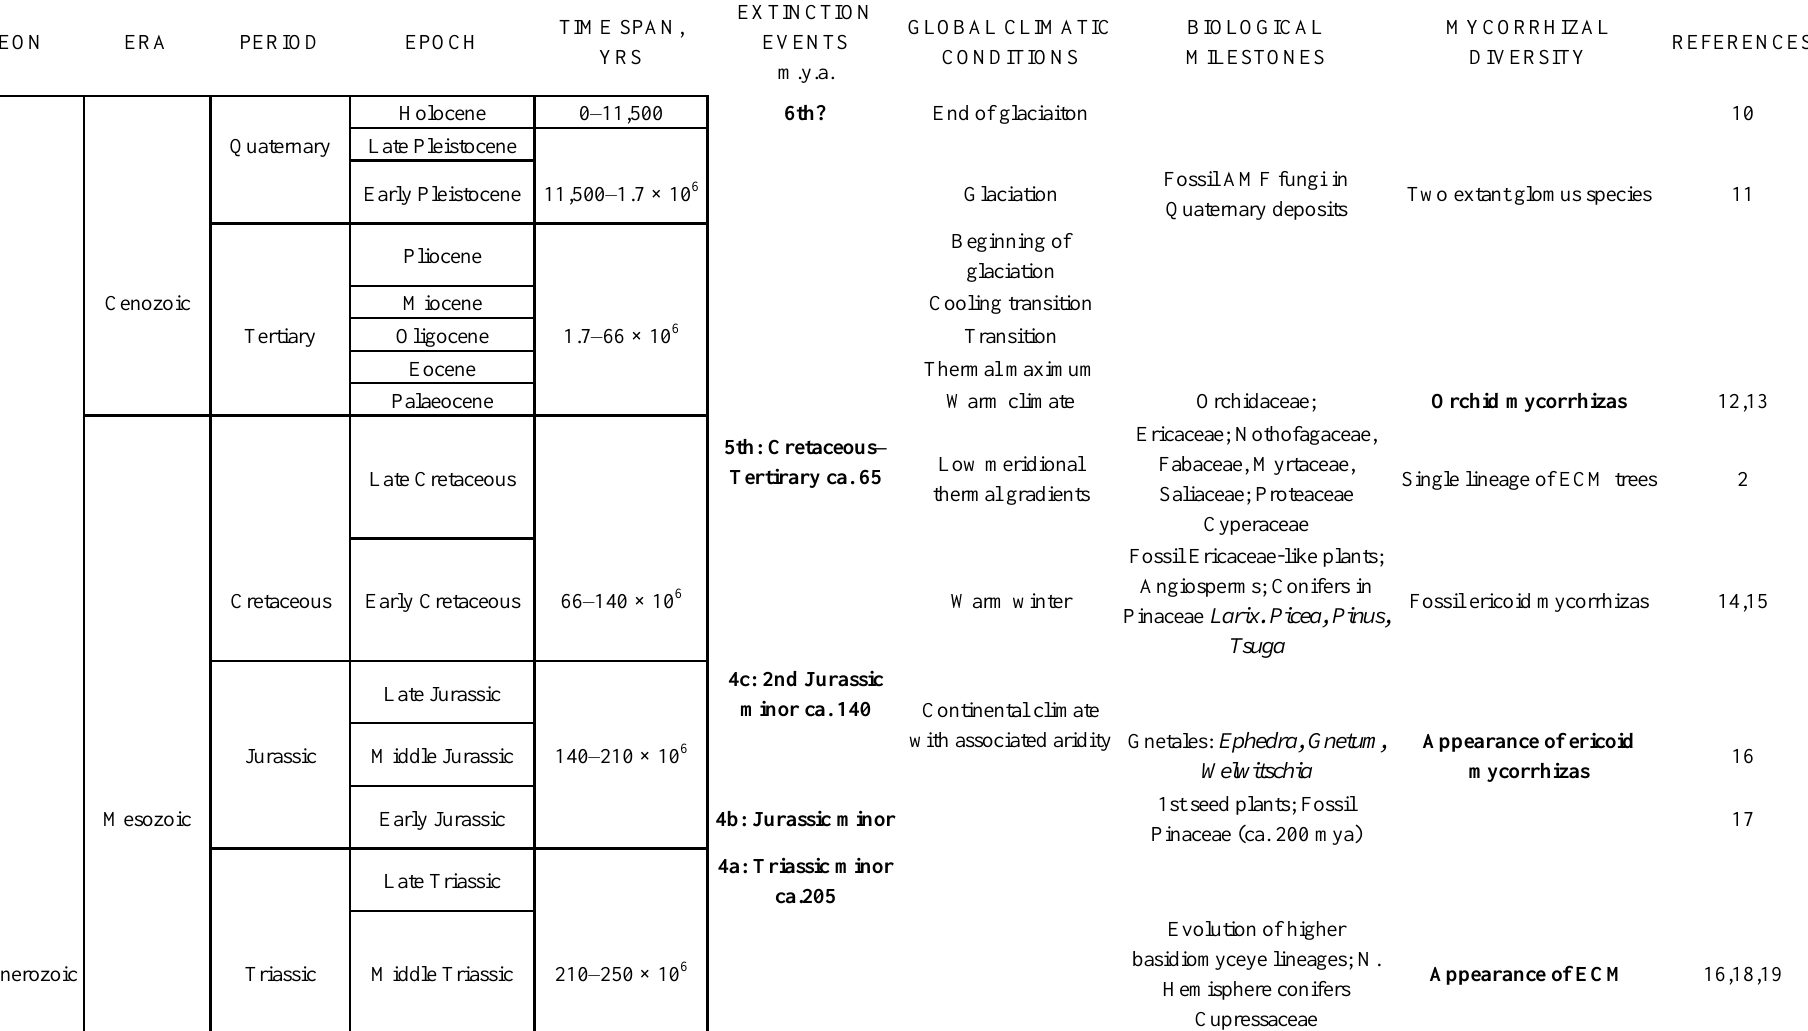
Table 2. Mycorrhizal diversity in the context of past